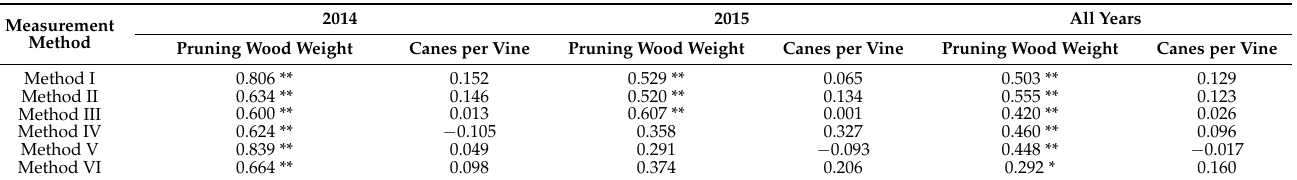
Table 3. Pearson’s correlation of the laser scanner measurements with the measured pruning wood parameters of the Sauvignon Blanc